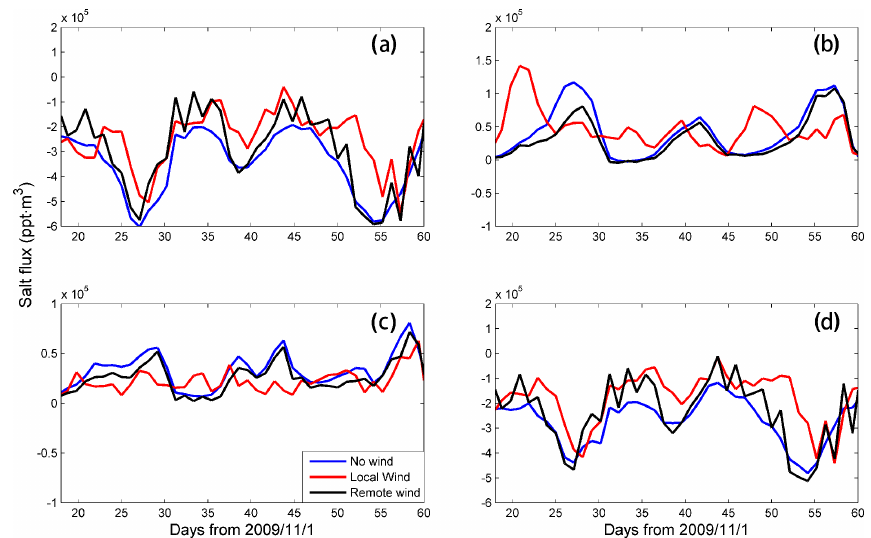
Figure 7. The salt flux under different cases at the cross section T2 of the estuary mouth. Panel (a) the advective; panel (b) the steady shear; panel (c) the tidal oscillatory; panel (d) the total salt